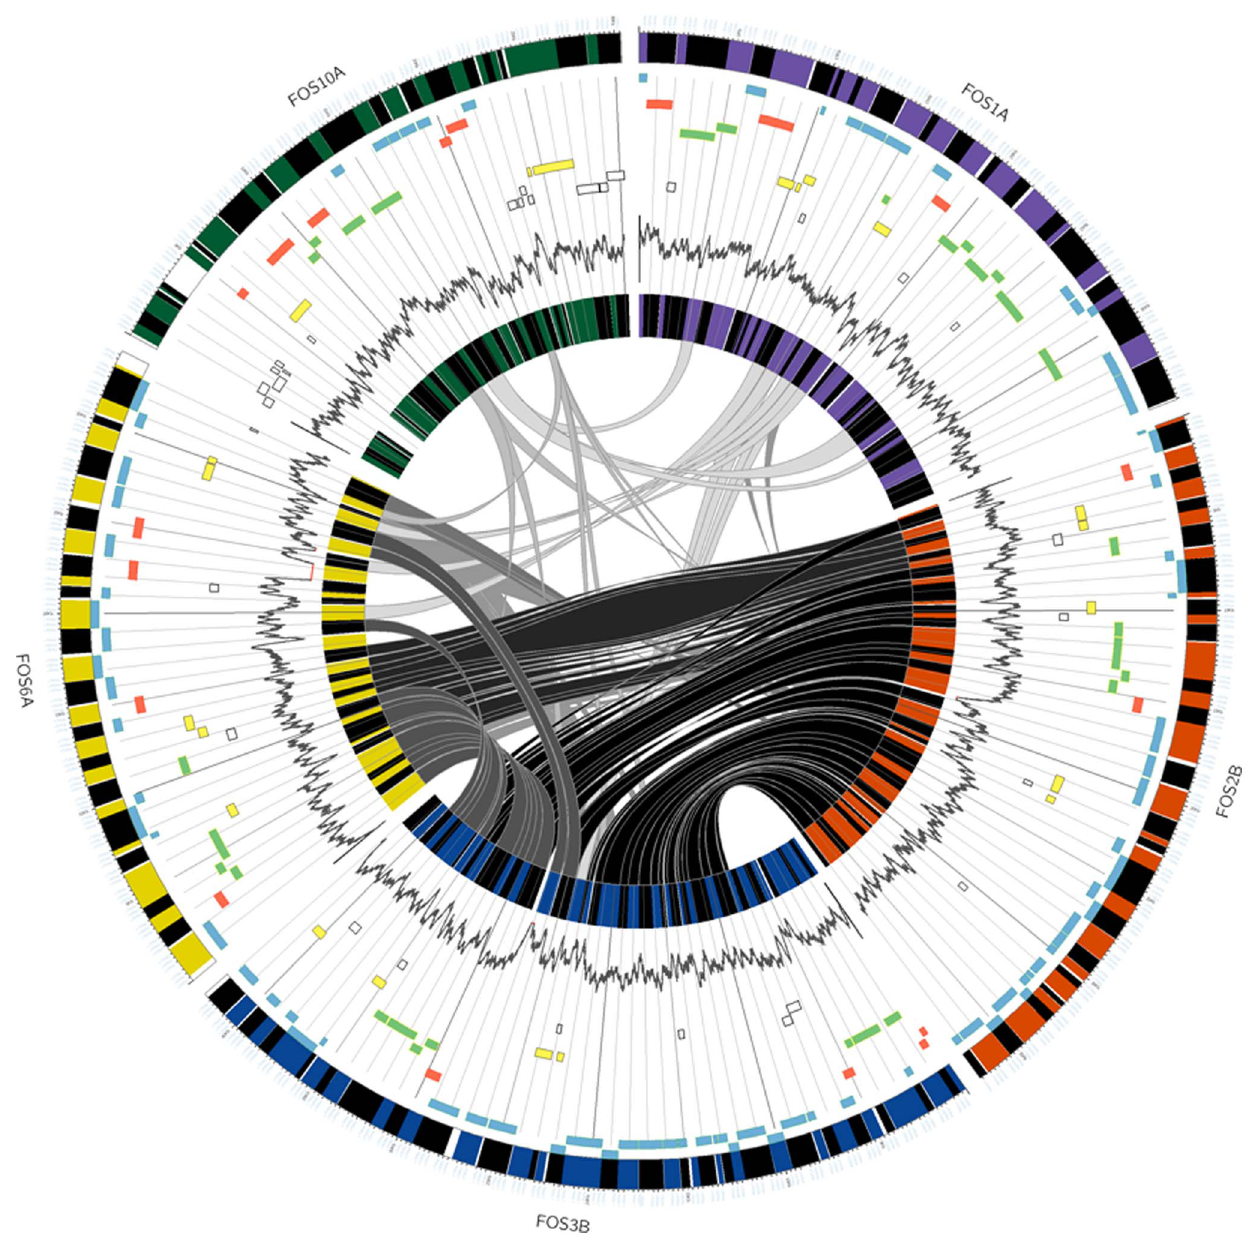
Figure 3. Circular representation of the five annotated fosmid clones and synteny between them. The outermost ring displays the different fosmids in different colors (dark green, purple, orange, dark blue and dark yellow). Annotated ORFs are shown in blocks (black is used to distinguish consecutive ORFs in the same fosmid). The connecting lines inside the circle join syntenic regions. The gray scale indicates the levels of synteny detected between the fosmids; the darkness is proportional to the number of genes in the two different fosmids (i.e., FOS 3B and FOS 2B showed more synteny, followed by FOS 3B and FOS 6A, and so on). Universal clusters of orthologous groups are shown in different colors (rings 2, 3, 4, 5); light blue: metabolism, light green: cellular processes and signaling, red: information storage and processing, light yellow: poorly characterized; white: not in COG. The innermost ring shows the G + C content (%). This figure was created using the Circos software (Krzywinski et al., 2009).